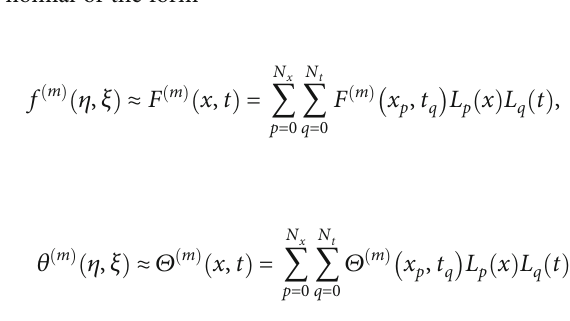
Figure 3: Temperature pro fi le for di ff erent values of λ when De = 0 : 1, N = 0 : 5, n = 0 : 5, f = NR = 0 : 2, Sc = 0 : 6, and Pr = 1